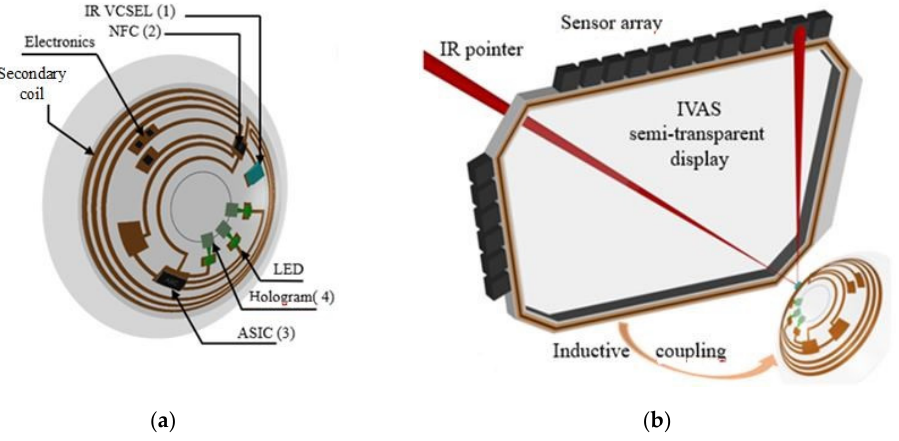
Figure 6. ( a ) SCL configuration when the sensor is not embedded in the lens. ( b ) Several 1D arrays (vertical) could be assembled horizontally (forming a 2D matrix) to include horizontal eye rotation.